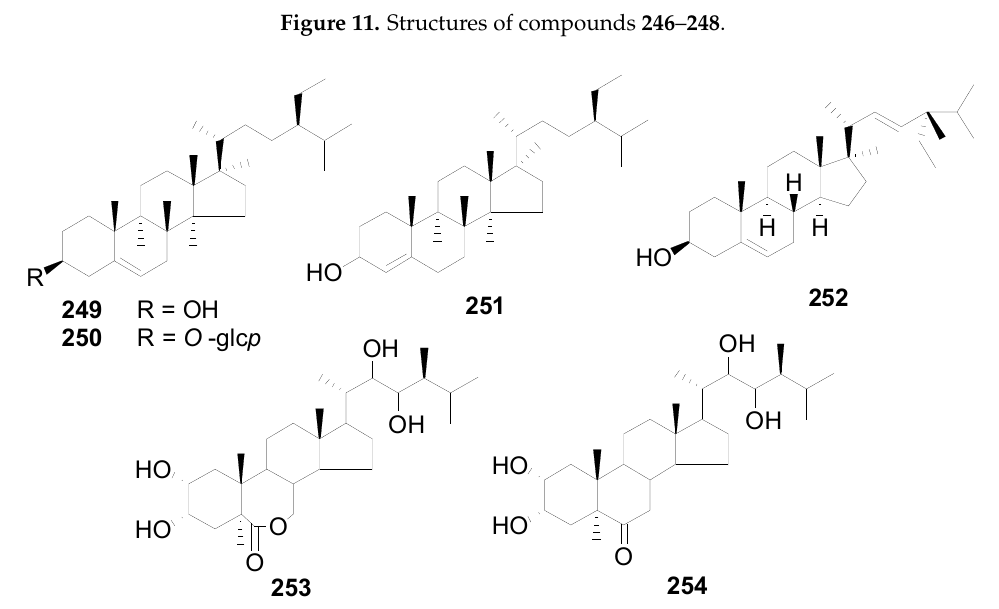
Figure 12. Structures of compounds 249 – 254 .